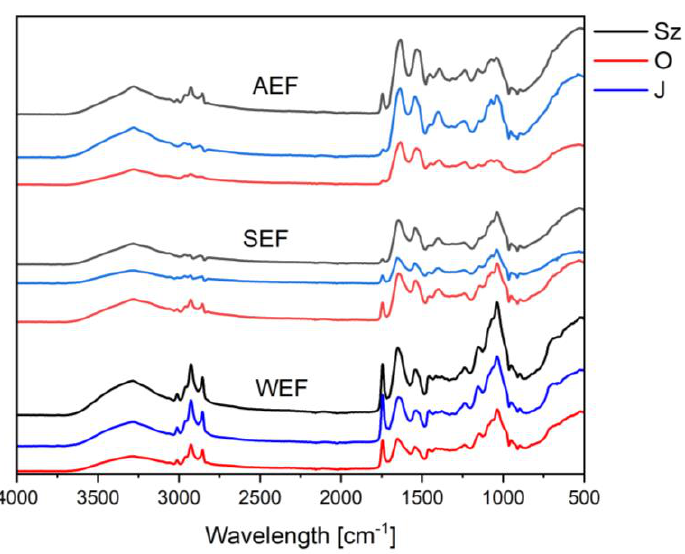
Figure 3. FT-IR spectra of the flaxseed protein fractions. WEF—water-extracted fraction; SEF—salt- extracted fraction; AEF—alkaline-extracted fraction; Szafir (Sz), Oliwin (O), and Jantarol (J) culti- vars.